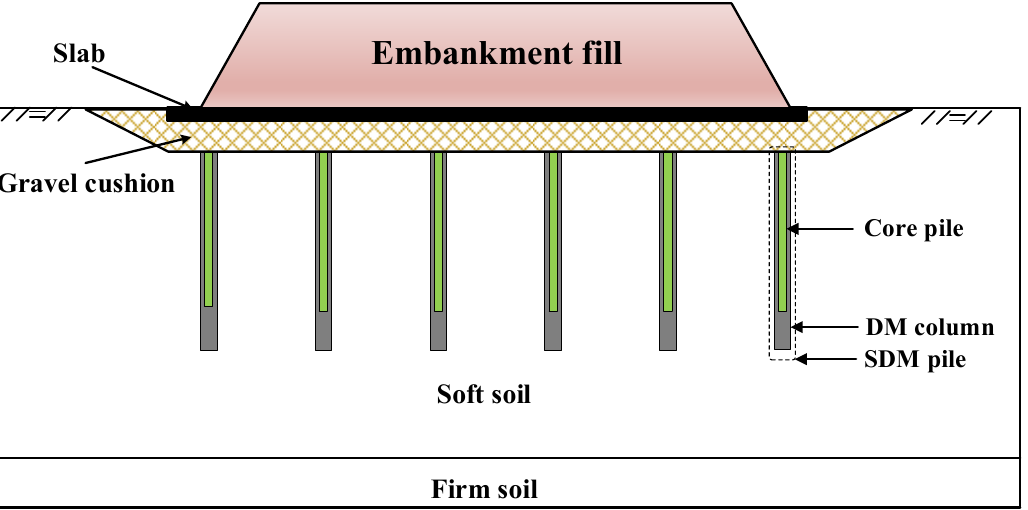
Figure 4. Schematic diagram of SDM column-supported embankment on soft soil [59].